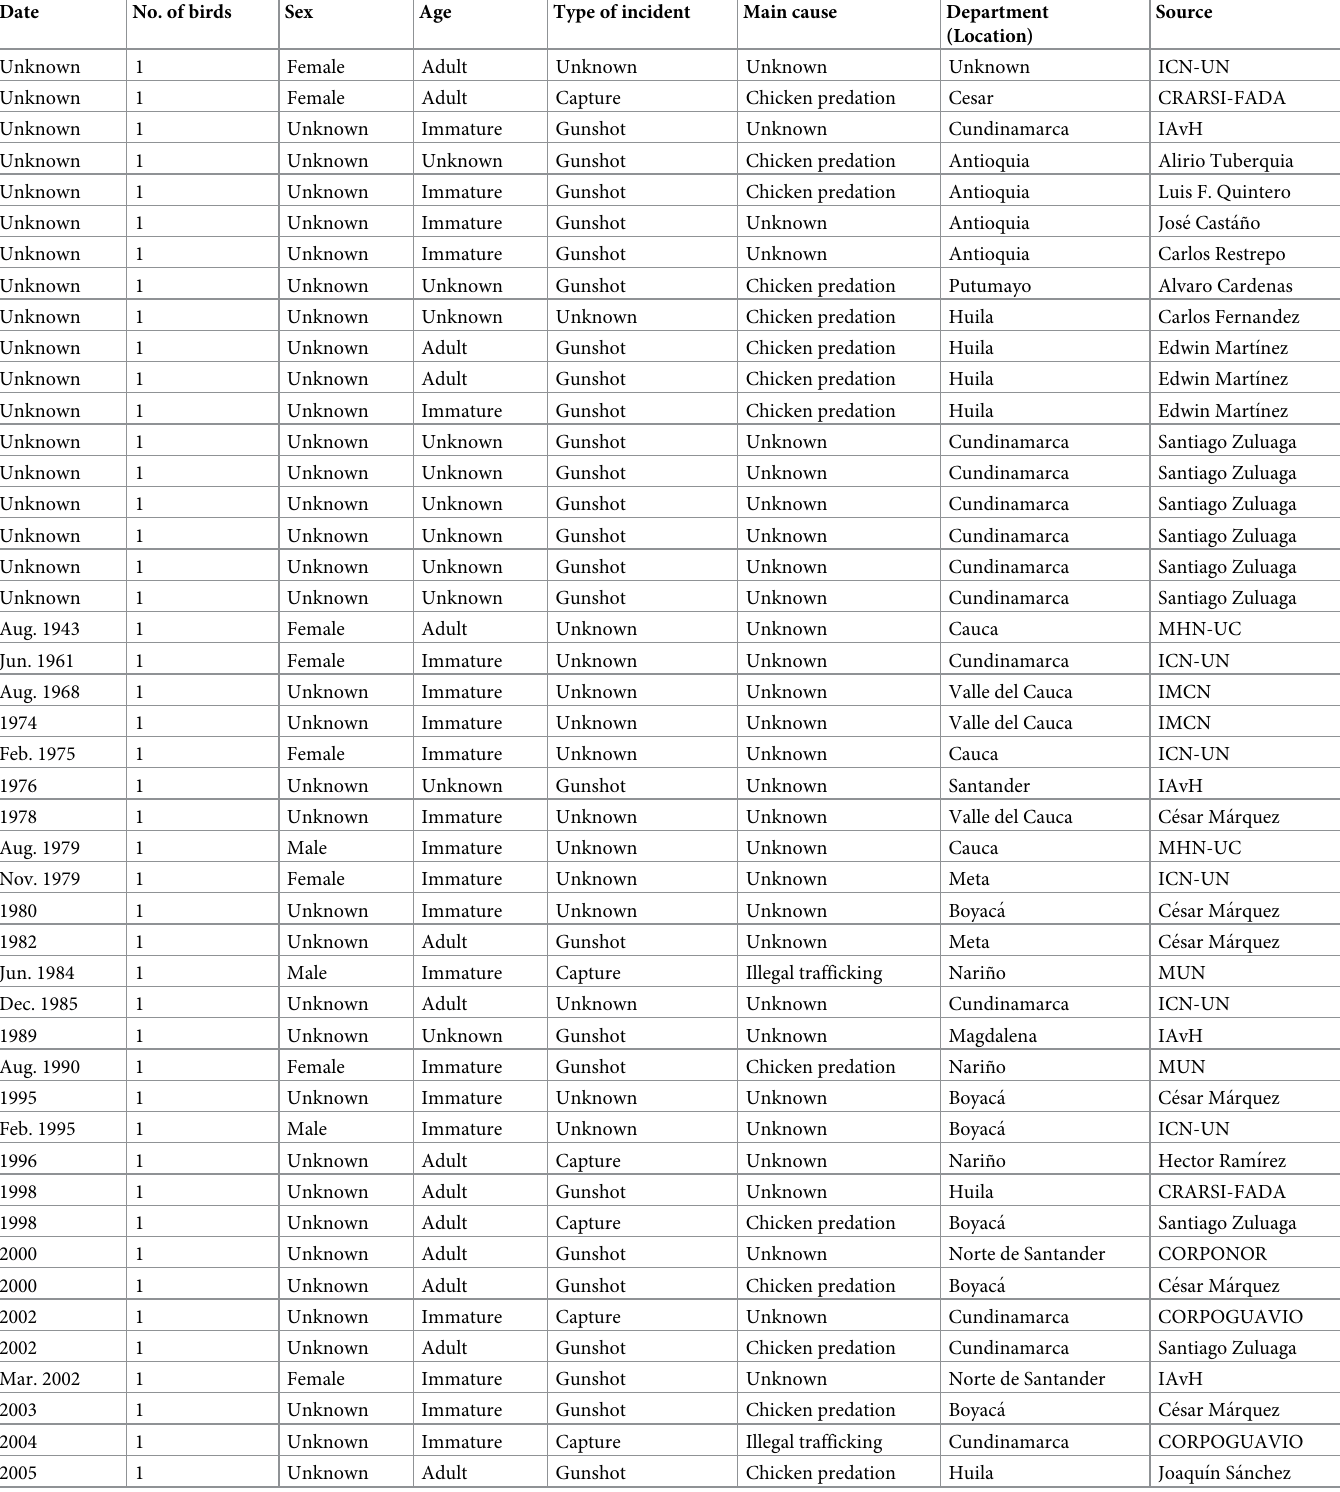
Table 4. Records of the hunting, capture, electrocution and illegal trafficking of Spizaetus isidori in Colombia, in chronological order. Date No. of